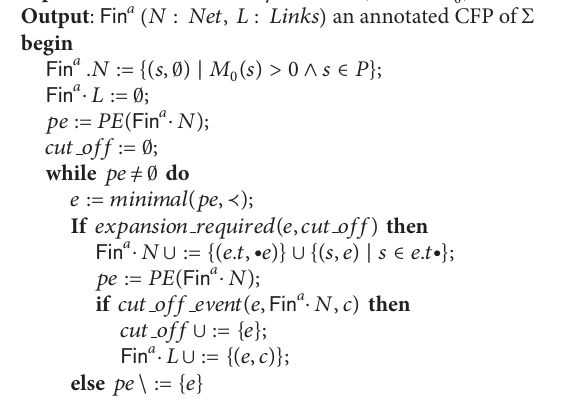
Algorithm 1: Computation of an annotated CFP via an adaption of Algorithm 4.7 in [7].